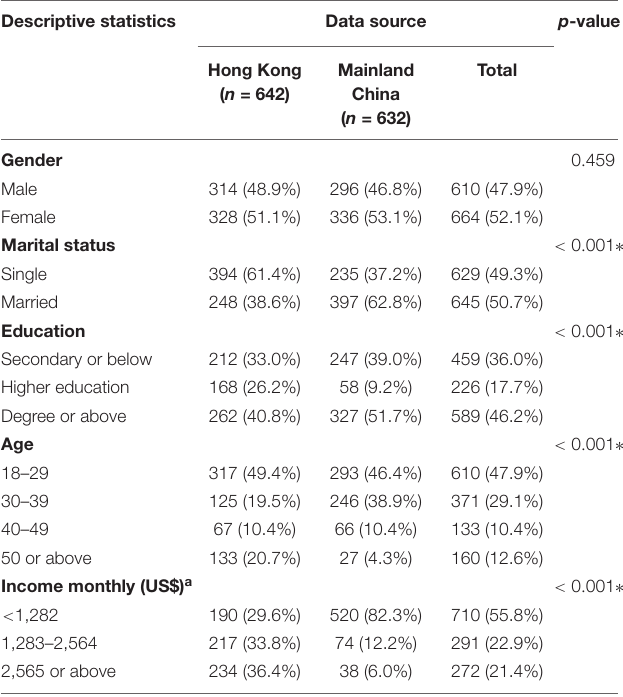
TABLE 1 | Descriptive statistics of samples of Hong Kong, Mainland China, and total ( N =